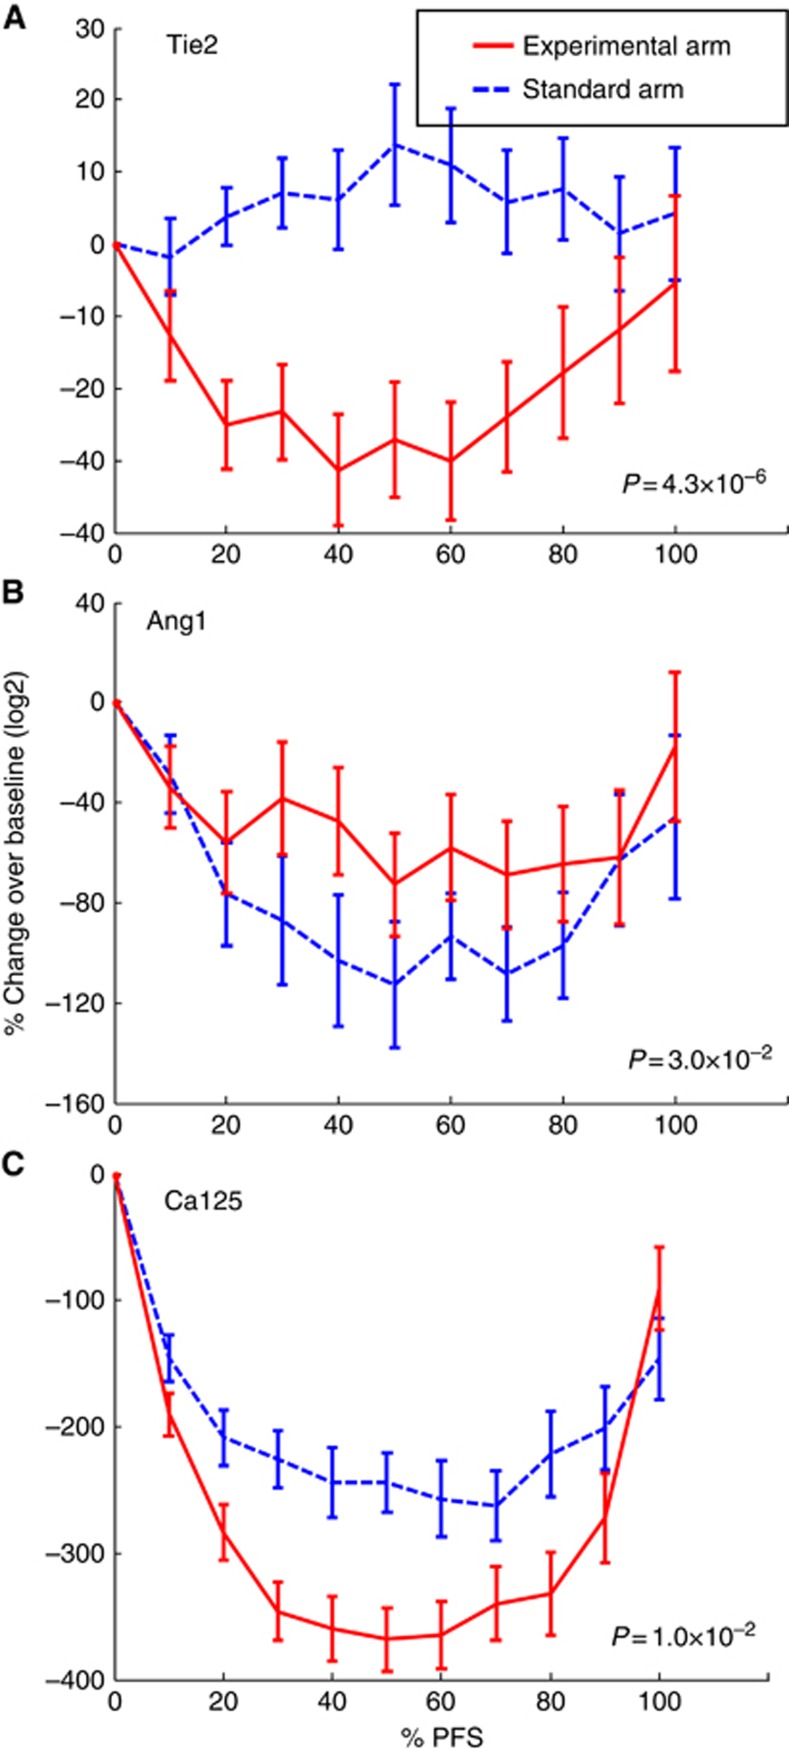
Mean trajectory of Ang1, Tie2 and Ca125.The dynamics of Ang1, Tie2 and Ca125, measured as mean percentage change over baseline (log ratio), were plotted against percentage of PFS. The red solid line refers to the experimental arm, and the blue dashed line refers to the standard arm. The data points are presented as ±s.e. Mann–Whitney U tests were used to compare the two arms at each 10% time interval and the minimum P-value was listed. P-values smaller than 0.0003 can be considered as indicating significant difference between the two arms, in accordance with Bonferroni correction for multiple comparison. As Ca125 (2c) was not subject to multiple comparisons, it achieved statistical significance with P=0.01. The first time point represents the mean of the two pre-treatment samples.